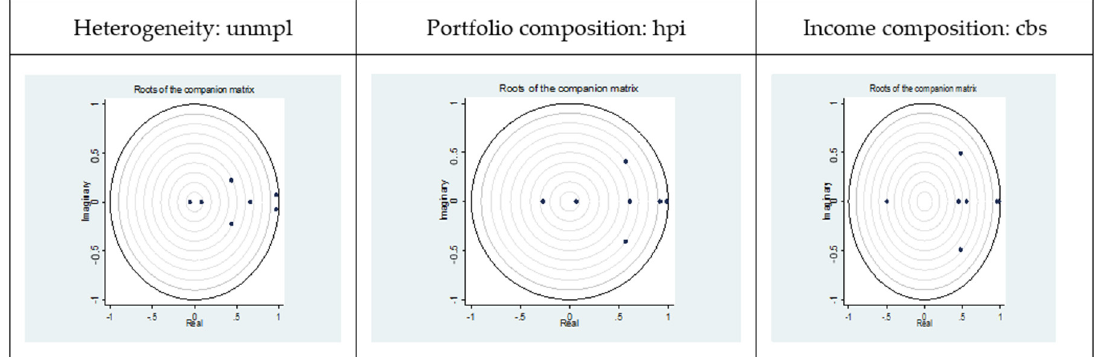
Figure 1. Eigenvalue stability condition. Note: All the eigenvalues lie inside the unit circle. PVAR satisfies stability condition. Source: Author’s illustration based on SWIID (Solt 2020; World Development Indicators 2022).